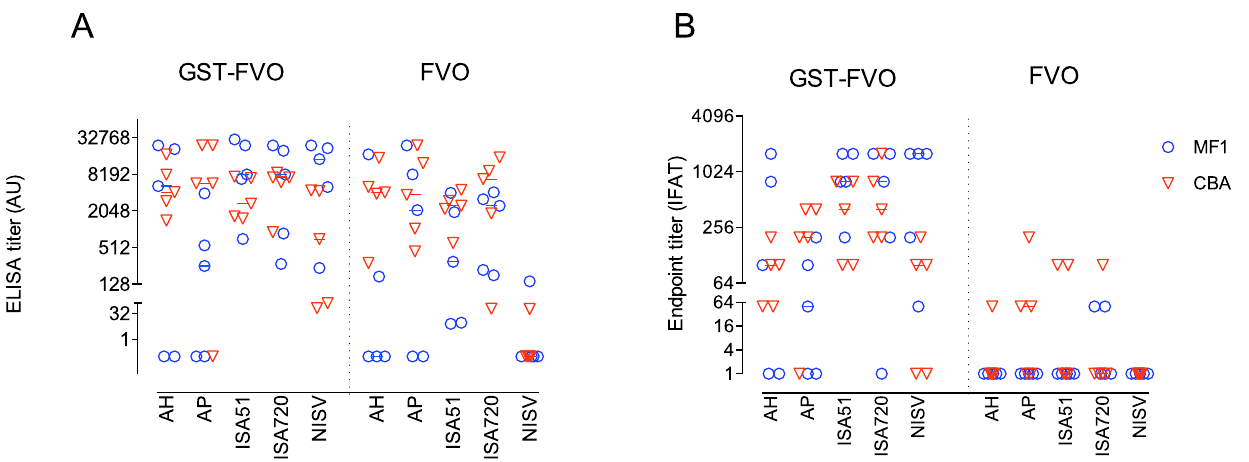
Figure 1. Immunogenicity and adjuvant testing of MSP-1 Block 2 proteins from the FVO isolate. Effect of adjuvants on antibody responses against MSP-1 Block 2. Groups of five outbred (MF1, circles) or inbred (CBA, inverted triangles) mice were immunized s.c. three times at 4 week intervals with FVO MSP-1 Block 2 formulated with the adjuvants as indicated on the X axis. AH, Alhydrogel; AP, AdjuPhos; ISA51, Montanide ISA51; ISA720, Montanide ISA720; NISV, Non-ionic surfactant vesicles. Two weeks after the last immunization, serum samples were tested by ELISA for antibody responses against thrombin-cleaved and purified FVO MSP-1 Block 2 (Panel A) and by IFA reactivity with P. falciparum parasites of the Wellcome isolate, which has the same Block 2 sequence as FVO (Panel B). ELISA and IFA titers were calculated as outlined in Materials and Methods. Data is shown on a log 10 scale as dotplots of serum reactivity for individual animals with the median level of Ab reactivity for each group indicated by a horizontal line.